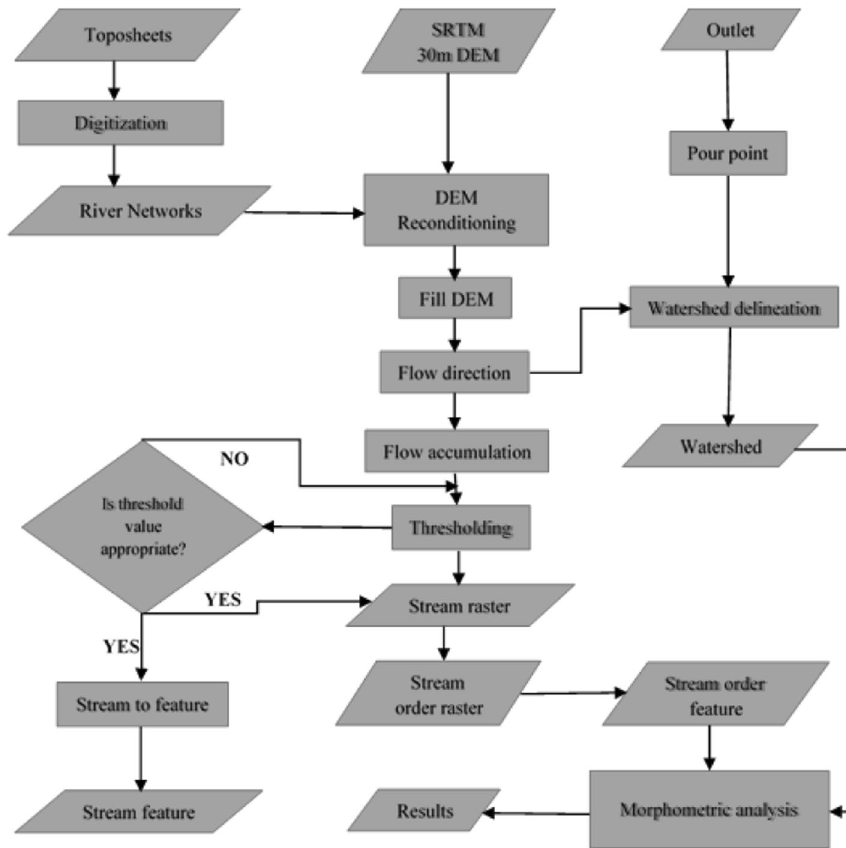
Fig. 2 Method for carrying out morphometric